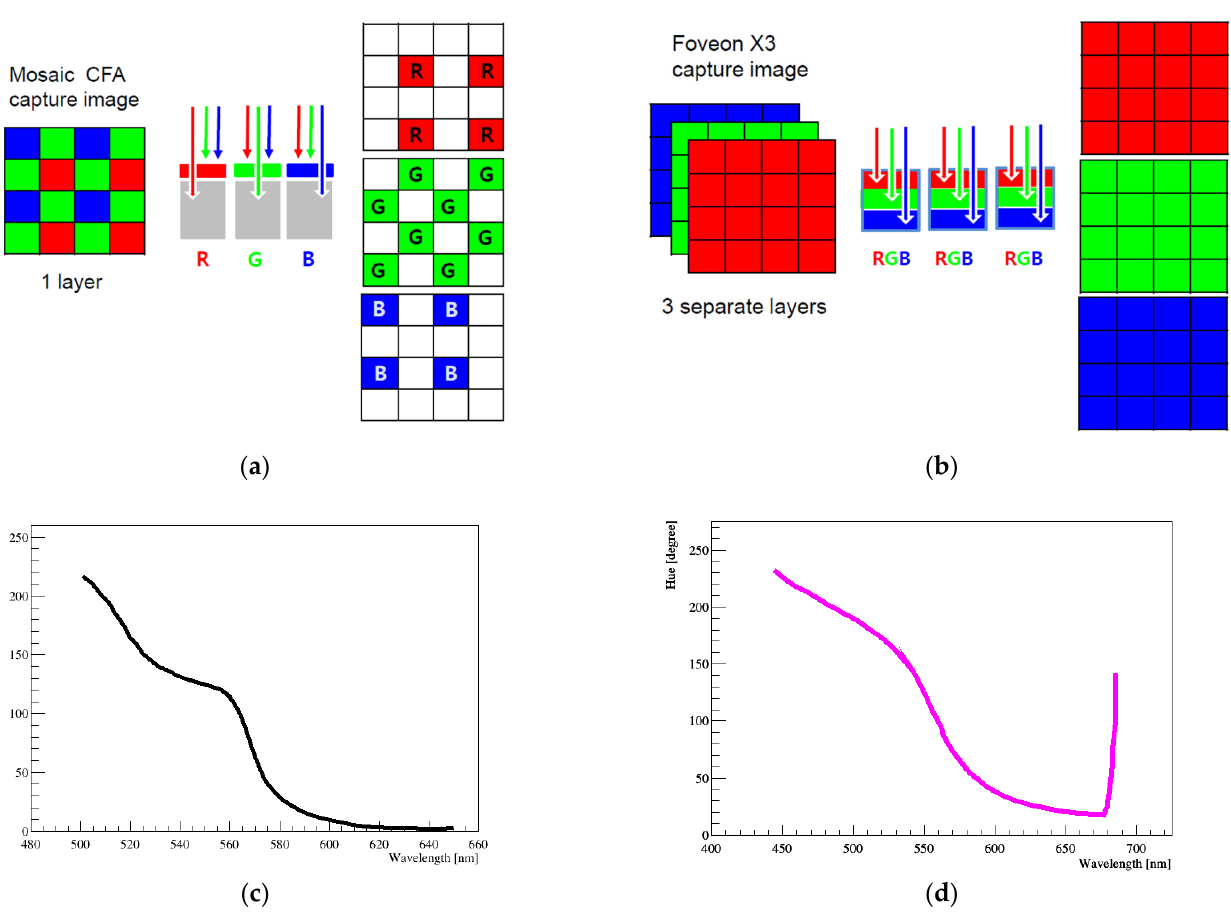
Figure 1. ( a ) Conventional mosaic captured using the CMOS sensor CFA technology. Color filters are applied to a single layer of pixel sensors and thus make a mosaic pattern. Only one wavelength of R, G, or B passes through a pixel, and one color is recorded. ( b ) Foveon X3 capture technology. The Foveon X3 image sensor has three separate layers of pixel sensors embedded in silicon. As a result, Foveon image sensors capture three colors at each pixel. ( c ) H-W response curve using CMOS CFA technology (for example, Canon 300D camera, manufacturer: Canon, Tokyo, Japan) adapted from [4]. RGB curves are input values to the camera. Plateau regions appeared at 530~560 nm and over 600 nm. ( d ) H-W curve based on the Foveon technology (for example, the SD 10 camera, manufacturer: Sigma Corporation, Bandai, Fukushima, Japan) adapted from [7,8]. The thickness of the line indicates uncertainties when the amount of light entering the camera is varied twice. The peak at the wavelength of around 675 nm is due to the poor camera response at the IR cut-off filter. All values beyond 675 nm are dumped to that